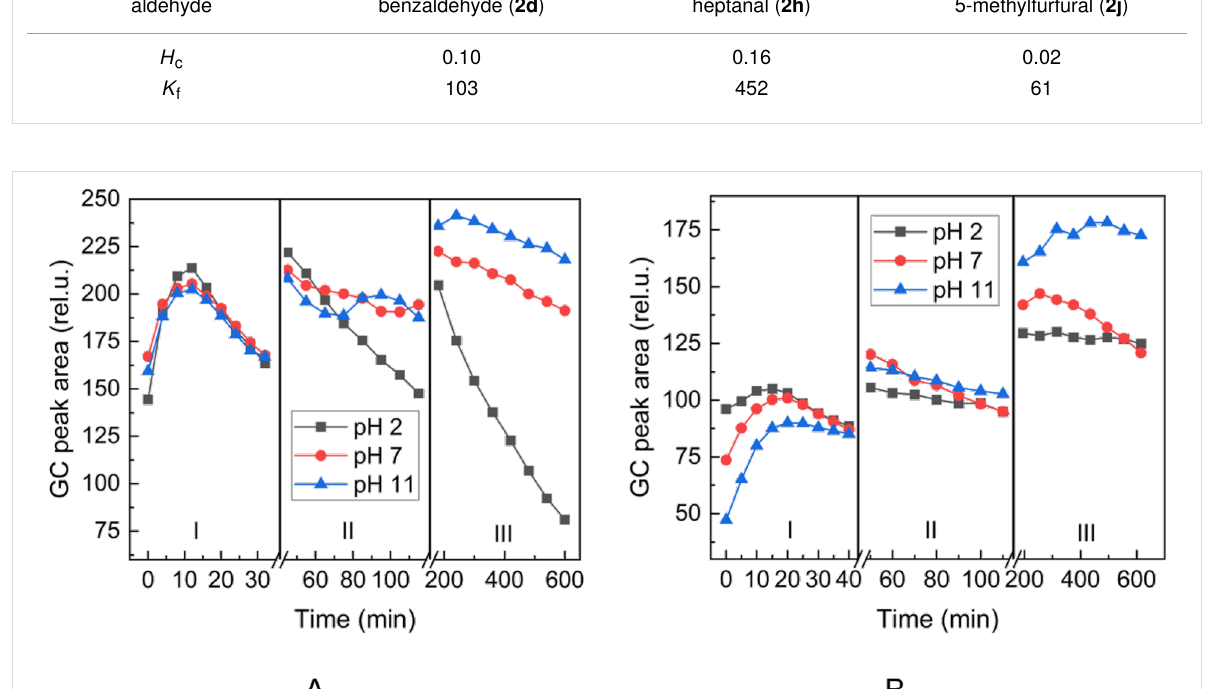
Table 1: Henry law constants and formation constants with β -CD (M − 1 ) of the three selected aldehydes (30 °C, aqueous solution).